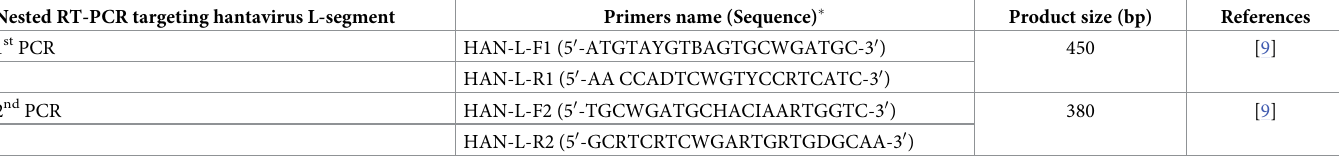
Table 1. Oligonucleotide primers used in this study. Nested RT-PCR targeting hantavirus L-segment